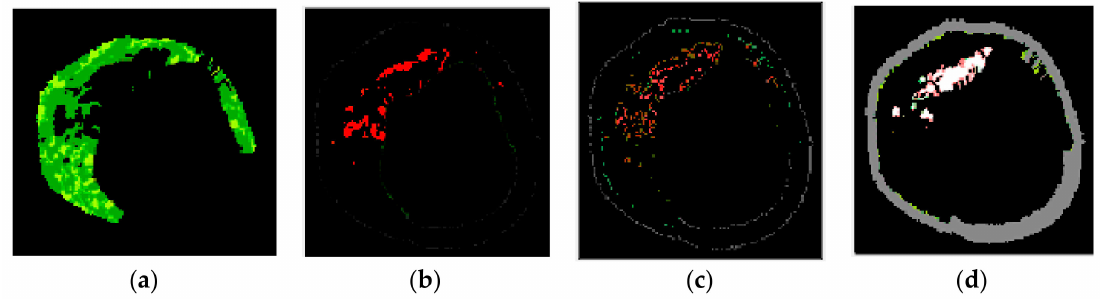
Figure 3. Clustering by K-means, ( a ) cluster 1, ( b ) cluster 2, ( c ) cluster 3, and ( d ) cluster